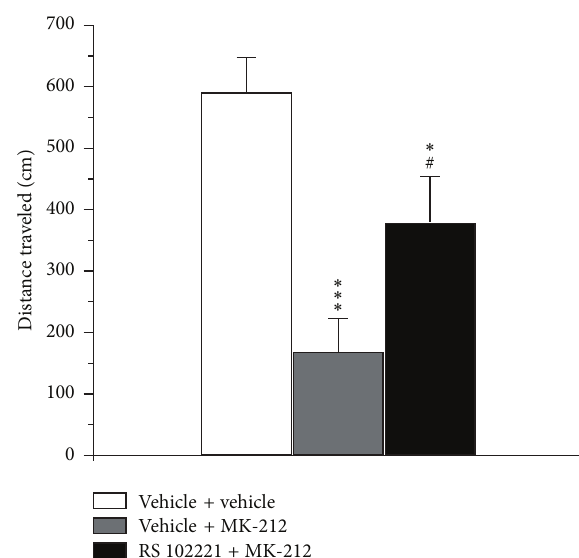
Figure 2: Effect of selective 5-HT 2 C receptor antagonist RS 102221 on MK-212-induced hypolocomotion in the open field test in CBA mice. RS 102221 (2mg/kg, i.p.) was administrated 10min prior to MK-212 injection (2mg/kg, i.p.) and 30 min prior to starting the behavioral test. The mice of control groups obtained double vehicle or vehicle plus MK-212 administration. The data are presented as mean ± SEM ( 𝑛 = 9 per group; ∗ 𝑝 < 0.05 , ∗∗∗ 𝑝 < 0.001 compared with double vehicle group; # 𝑝 < 0.05 compared with vehicle plus MK-212 group).